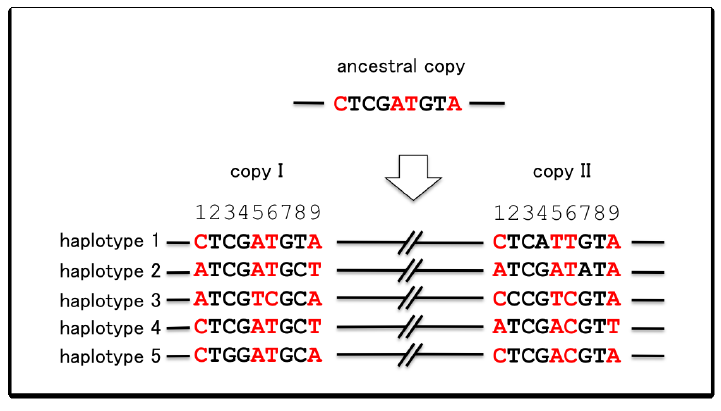
Figure 4. Hypothetical polymorphism data from a pair of duplicated genes with sample size 5. Positions where the nucleotides are in red contain individuals that have the same (shared) substitutions in both copies, referred to as shared polymorphisms. For instance, in position 1, haplotype 2 contains the substitution of C to A in both copies. The same applies to haplotype 3 in positions 5 and 6 (AT to TC), and haplotype 4 in position 9 (A to